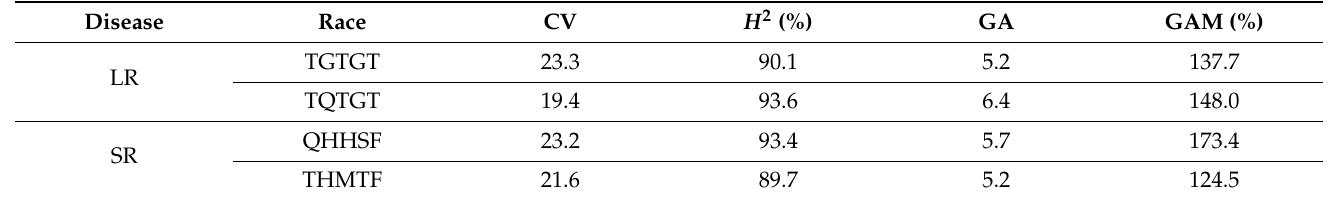
Table 2. Statistical parameters for the reaction of the tetraploid wheat collection to races of P.